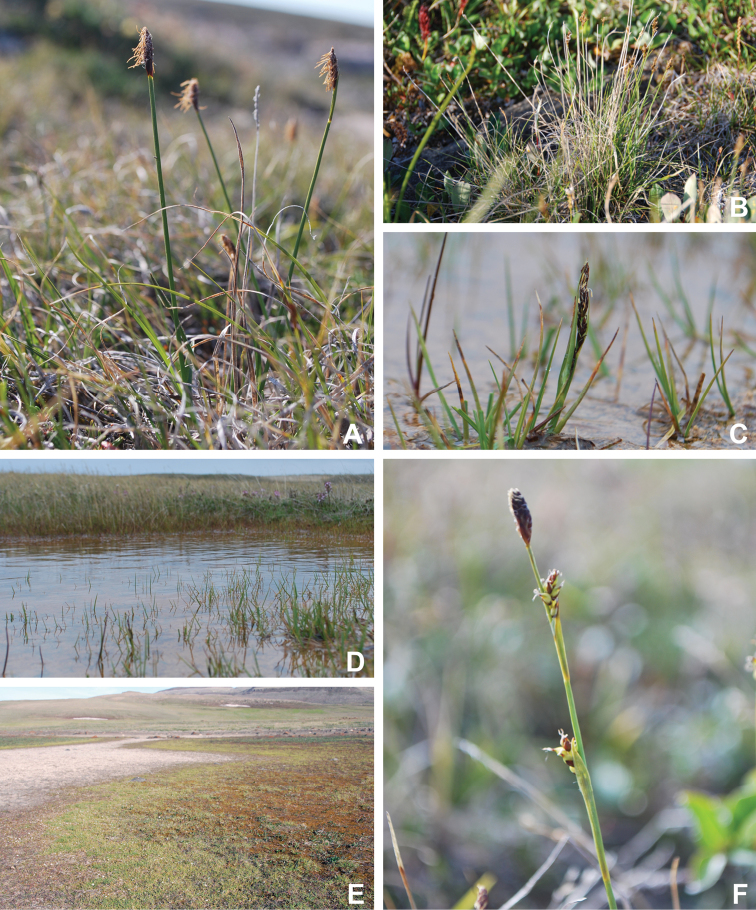
ACarex
scirpoidea
subsp.
scirpoidea habit, staminate plants BCarex
simpliciuscula
subsp.
subholarctica habit, Kuujjua River, NT, 18 July 2010 CCarex
subspathacea habit DCarex
subspathacea habitat ECarex
ursina habitat, Gillespie et al. 9964FCarex
vaginata inflorescence. Photos A, C, D, F by B.A. Bennett and B, E by J.M. Saarela.